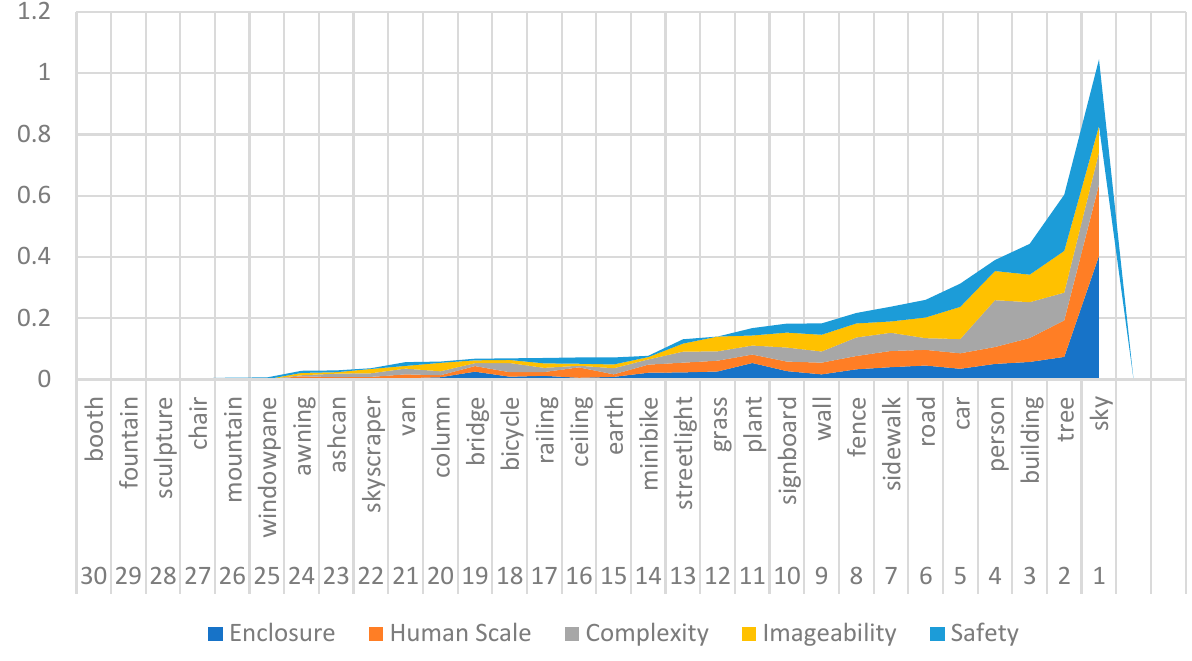
Figure 4. Gini importance of each objective feature of subjective perceptions’ prediction.